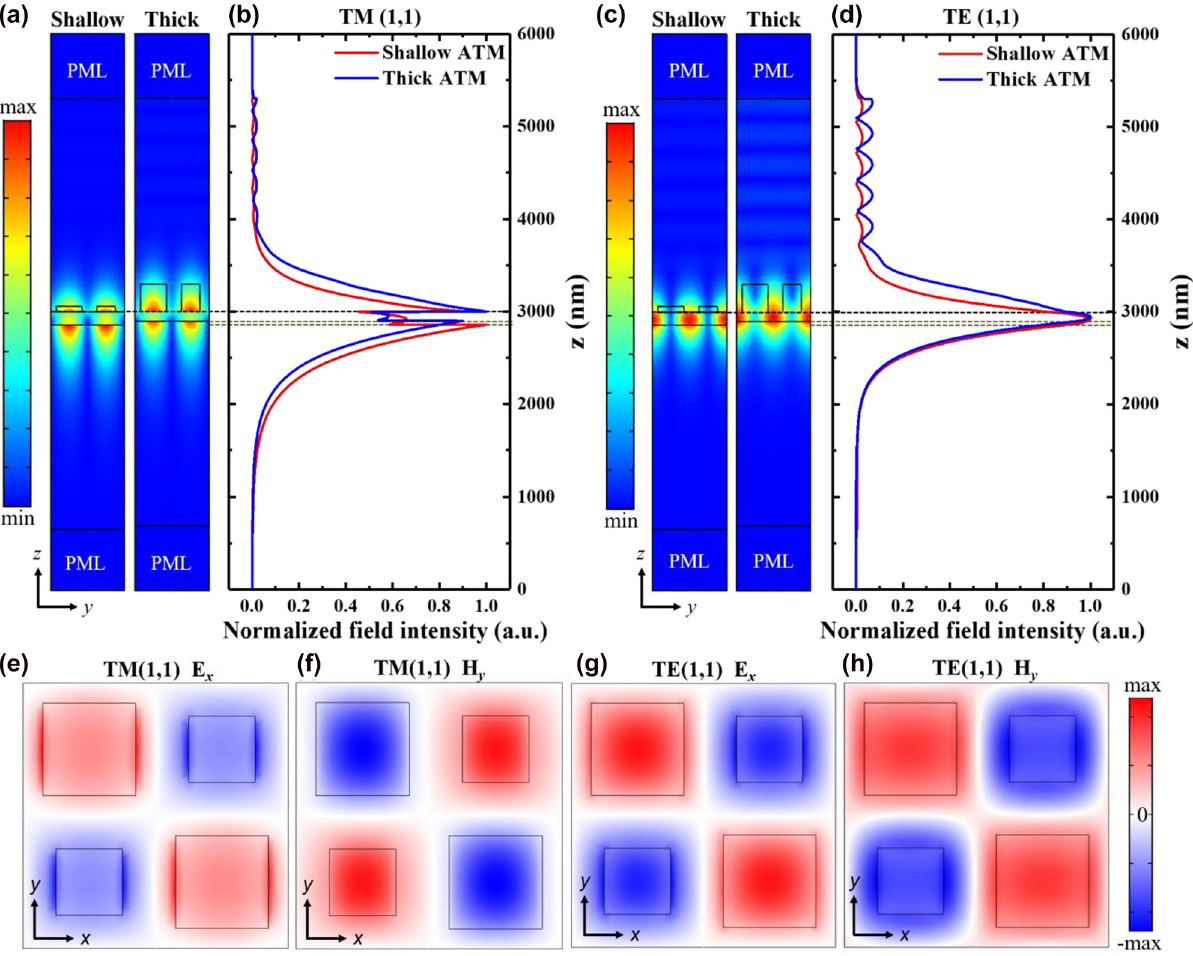
Figure 4: Optical field distribution of ATM structures. (a) Resonance electric-field distribution and (b) normalized field intensity across the z axis of ATM structures under TM (1,1) mode. (c) Resonance electric-field distribution and (d) normalized field intensity across the z axis of ATM structures under TE (1,1) mode. (e–h) Simulated in-plane field distribution of the resonance mode for ATM structure. For shallow ATM, w = 60 nm, and t = 140 nm. For thick ATM, w 200 nm, t g w g